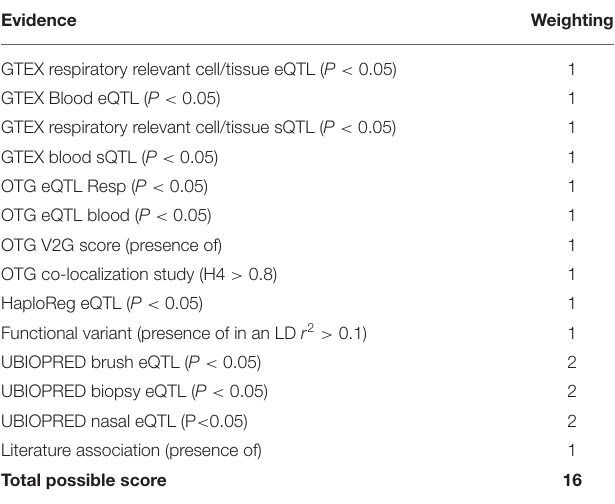
TABLE 3 | Scoring system for signal to gene analyses.